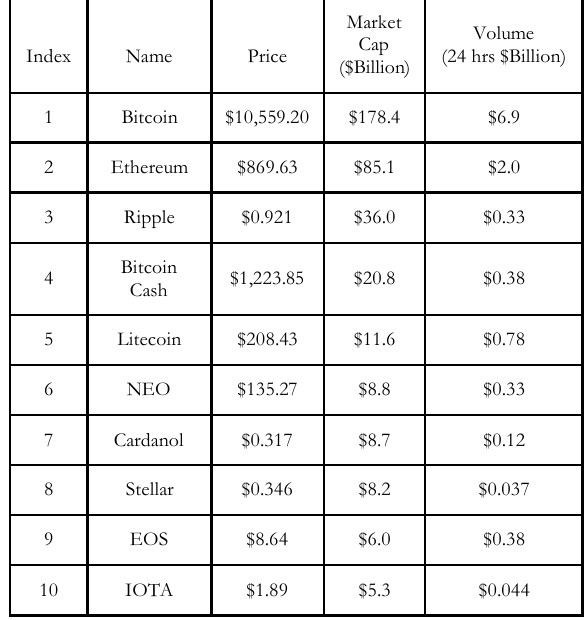
Table 1: Top Ten Cryptocurrencies (Source: CoinMarketCap.com, data as of February 28th,